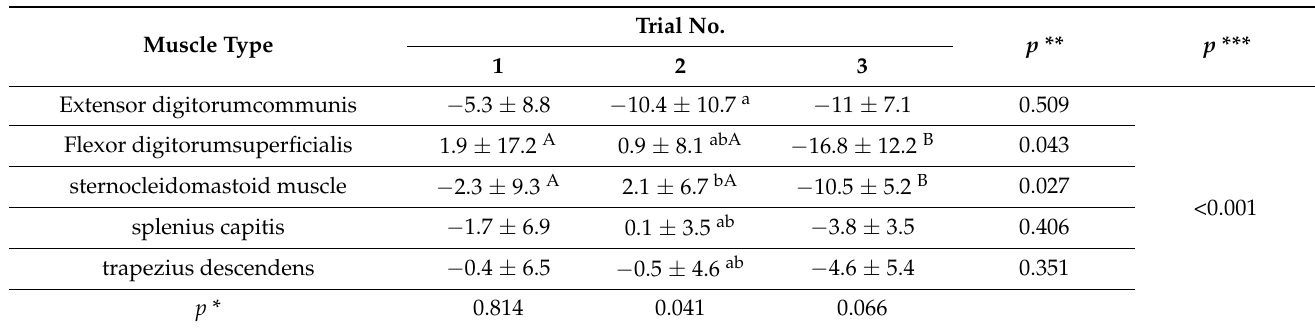
Table 4. Comparison of intraoral scanning task mean muscle fatigue (%) in the first, second, and third